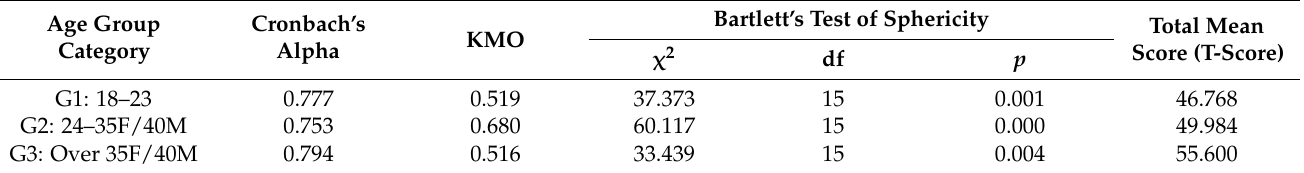
Table 1. Statistical analysis of the data for the Five-Factor Personality Questionnaire (CP5F).